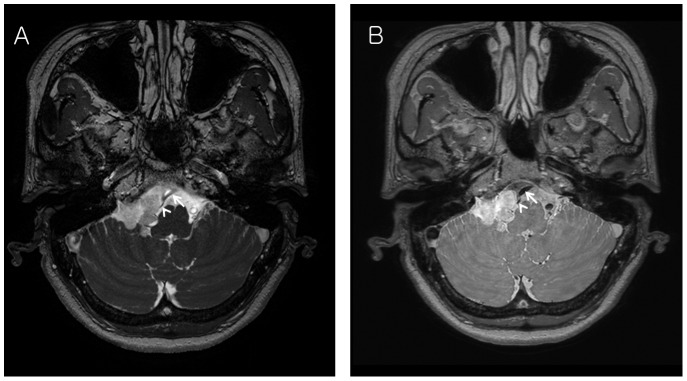
A 54-year-old female with a schwannoma in the right CPA.(A) On Gd enhanced 3D bFFE axial image, basilar artery (white arrow) and right AICA (arrow head) adjacent to tumor border are not demarcated due to various signals from vessels. (B) On Gd enhanced 3D PDDE, basilar artery (white arrow) and right AICA (arrow head) adjacent to tumor border are clearly visualized due to excellent black blood imaging.